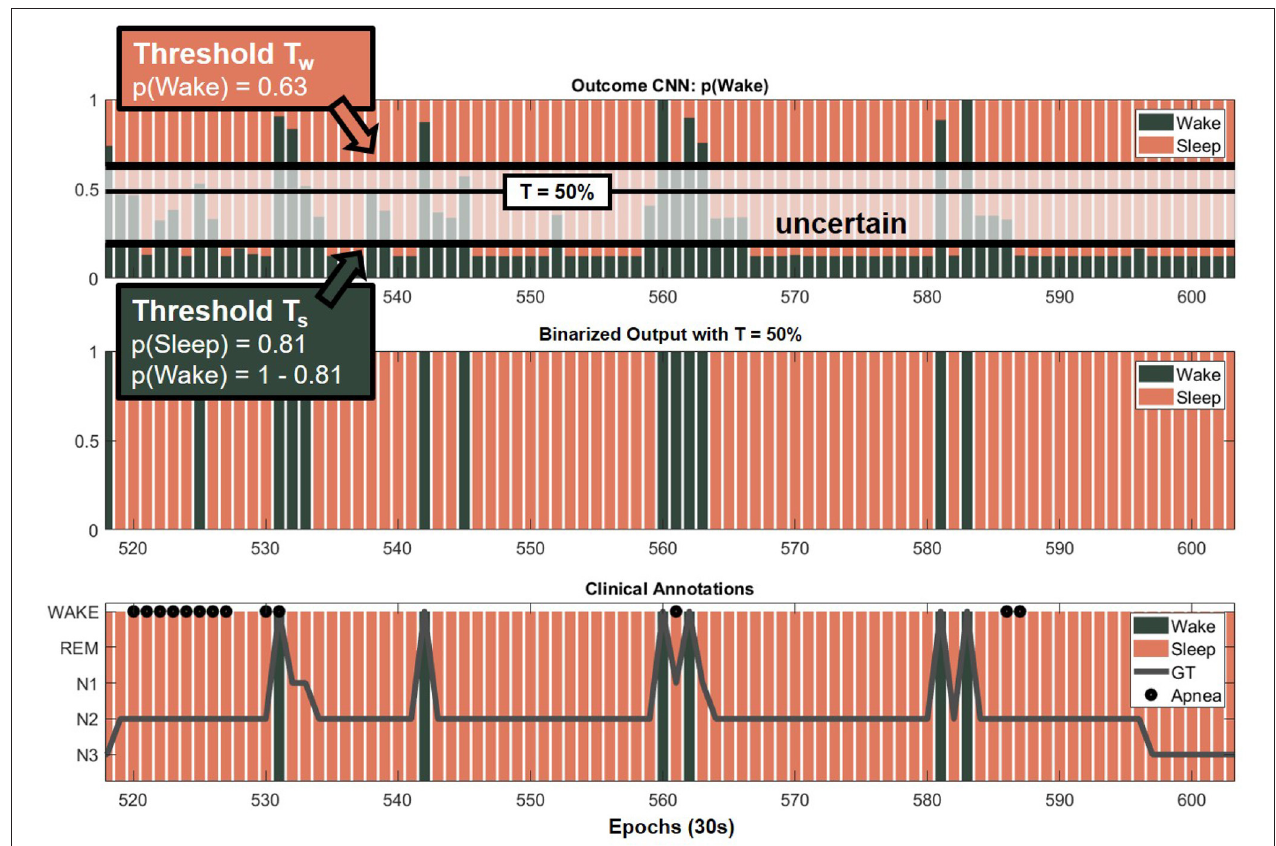
FIGURE 3 | Definition of uncertain epochs. The top row represents the outcome of the CNN of each epoch as p ( Wake ) (green) and p ( Sleep ) = 1 − p ( Wake ) (red) (see section 2.3.1). A distinction was made between confident and uncertain predicted epochs by defining confidence thresholds. The second row shows the predicted sleep-wake classification with the default threshold at 50%. The last row shows the ground truth (GT) sleep stages which were clinically